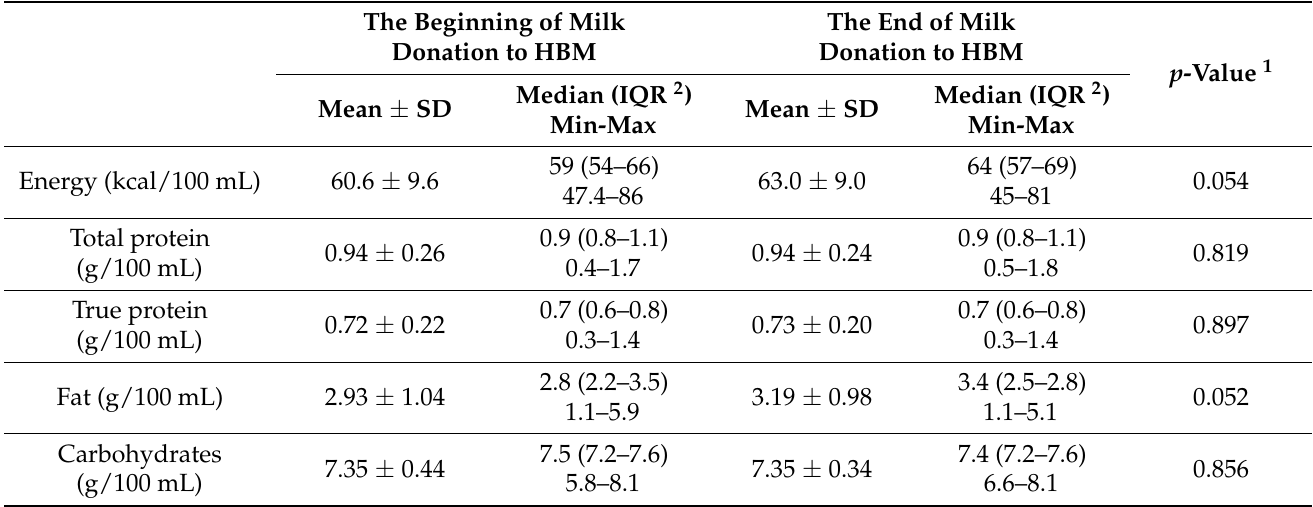
Table 3. Comparison of DHM composition in the beginning and at the end of milk donation to